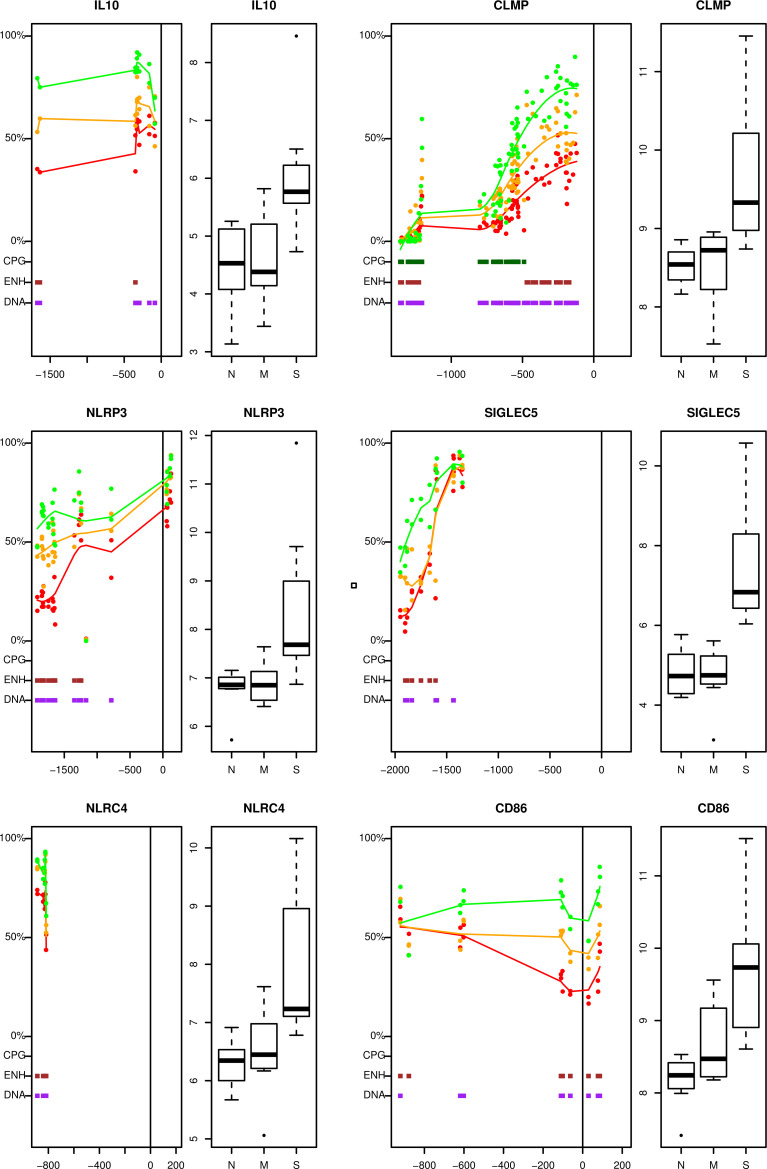
Selection of the most specifically expressed and hypo-methylated genes in severe ulcerative colitis.On the left of each individual illustration the differences in relative methylation levels between normal samples (green), mild UC (orange) and severe UC (red) is shown. Red, green, and orange lines represent the mean relative methylation for severe UC, mild UC and normal samples. The transcription start-site (TSS) is indicated as a vertical line. The x axis is numbered relative to the transcription start site, where minus indicated number of base pairs downstream for TSS (200 bp), and positive number of base pairs upstream from TSS (up to 2000 bp). UCSC genome browser mapped CPG sites (CPG) indicated in dark green, enhancer sites (ENH) indicated in brown, and DNAse1 sites (DNA) indicated in purple. On the right, boxplots of DESEQ2 log2 normalised values for the gene of interest in normal control (N), mild UC (M) and severe UC (S) are shown. Genes are indicated: interleukin 10 (IL10), CXADR- like membrane protein (CLMP), NLR family pyrin domain containing 3 (NLRP3), sialic acid binding Ig like lectin 5 (SIGLEC5), NLR family CARD domain containing 4 (NLRC4) and T-lymphocyte activation antigen CD86 (CD86).